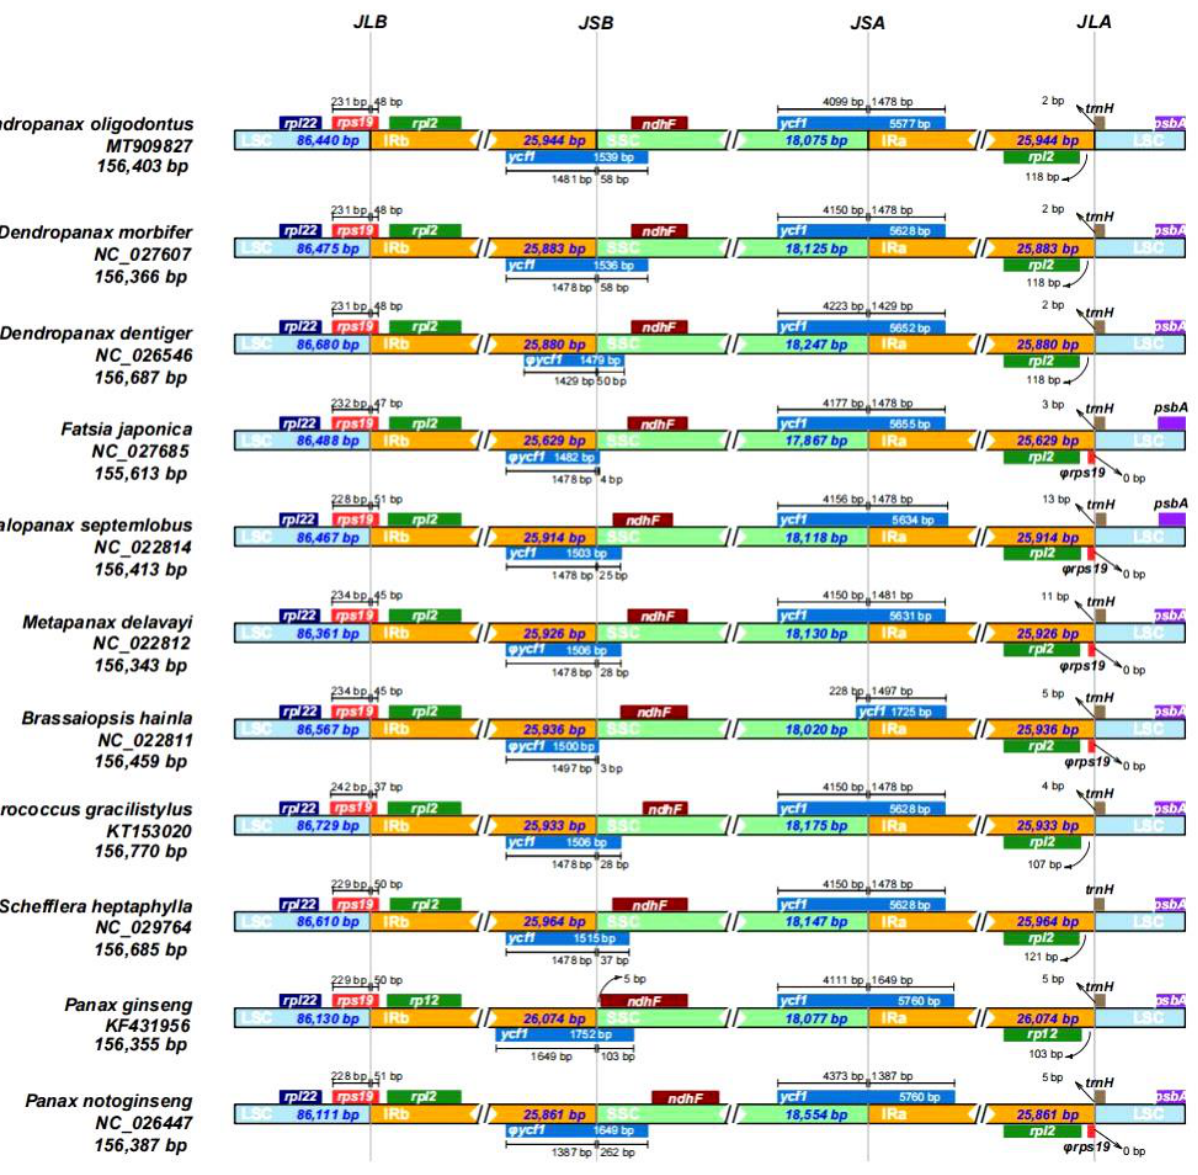
Figure 5. Comparison of the boundaries of the LSC, SSC, and IR regions of the 11 chloroplast genomes. JLB: junction between LSC and IRb; JSB: junction between SSC and IRb; JSA: junction between SSC and IRa; JLA: junction between LSC and IRa.